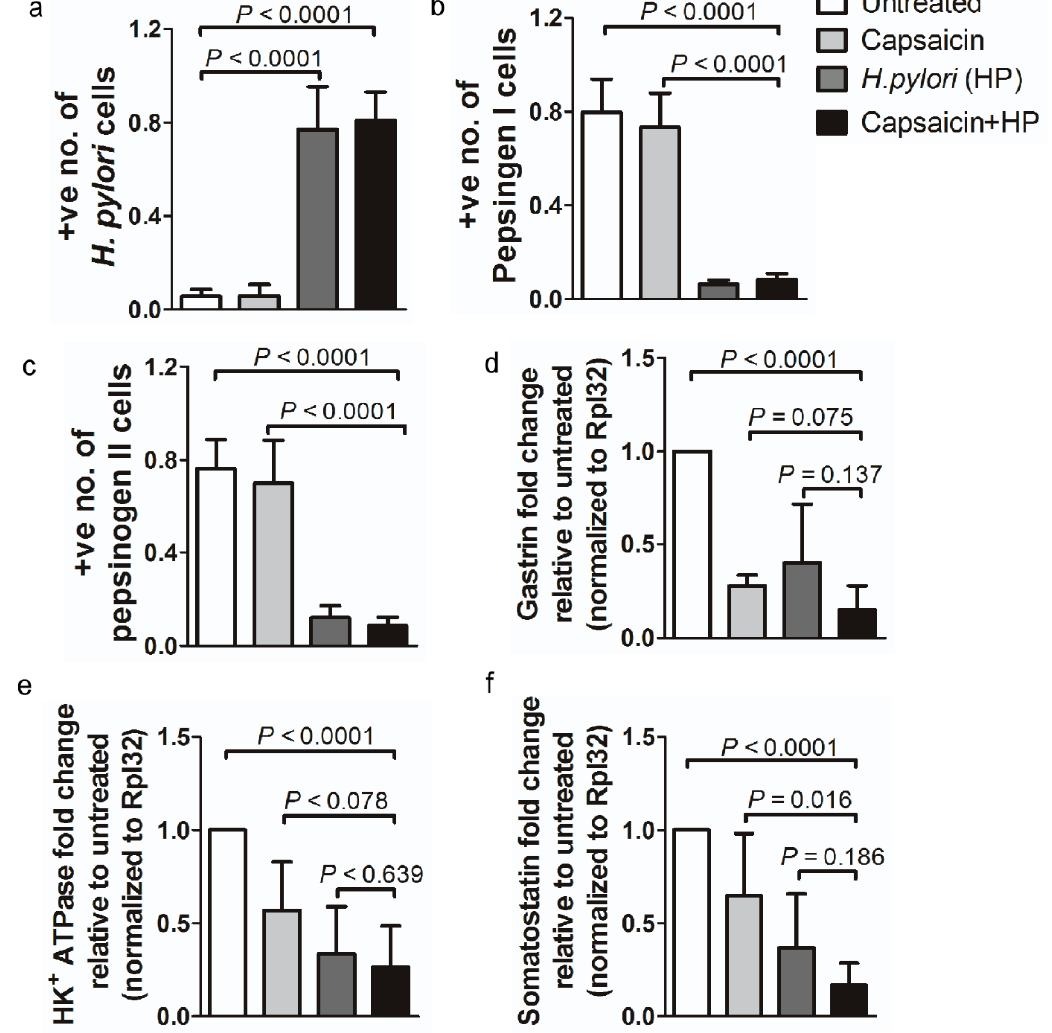
Figure 2. Immunohistochemical and qPCR analysis of gastric disease mouse models. Immunohistochemical detection of pepsinogen I and II and H. pylori expression in gastric tissues from mice treated with both capsaicin and H. pylori . Paraffin-embedded gastric tissues were stained to detect H. pylori , pepsinogen I, or pepsinogen II, respectively. Quantitative immunohistochemical detection of ( a ) H. pylori , ( b ) pepsinogen I, or ( c ) pepsinogen II expression. A strong intensity was observed in untreated gastritis tissue compared to gastric cancer tissues. Scale bars represent 100 μ m (10×), and the scale bar in the inset images represents 20 μ m (40×). A score of 1 denotes the highest staining, whereas a score of 0 indicates negative staining. mRNA analysis of ( d ) gastrin , ( e ) H + K + ATPase , and ( f ) somatostatin by qPCR. Average fold change in mRNA relative to untreated control ( n = 5/cohort).